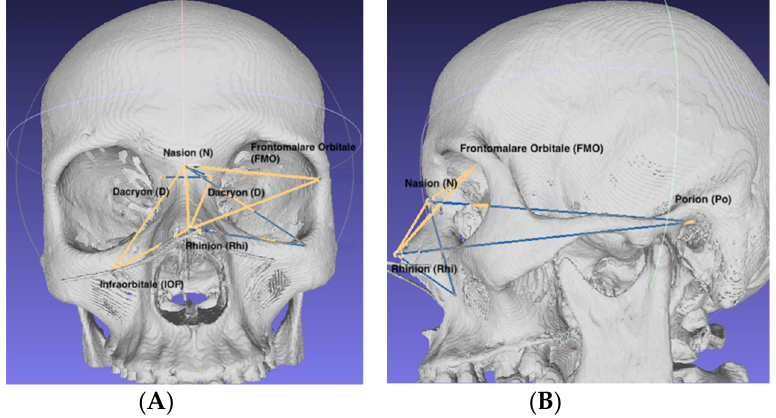
Figure 4. Performing measurements on the virtual 3D model; ( A ) anterior view; ( B ) lateral view.